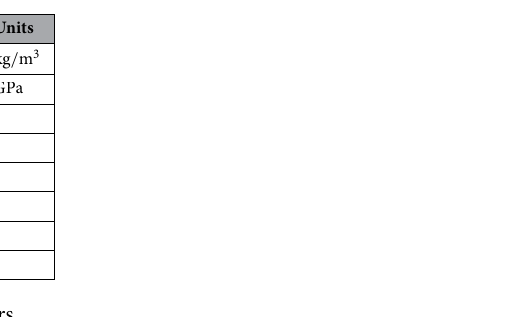
Table 1. Material properties and fatigue